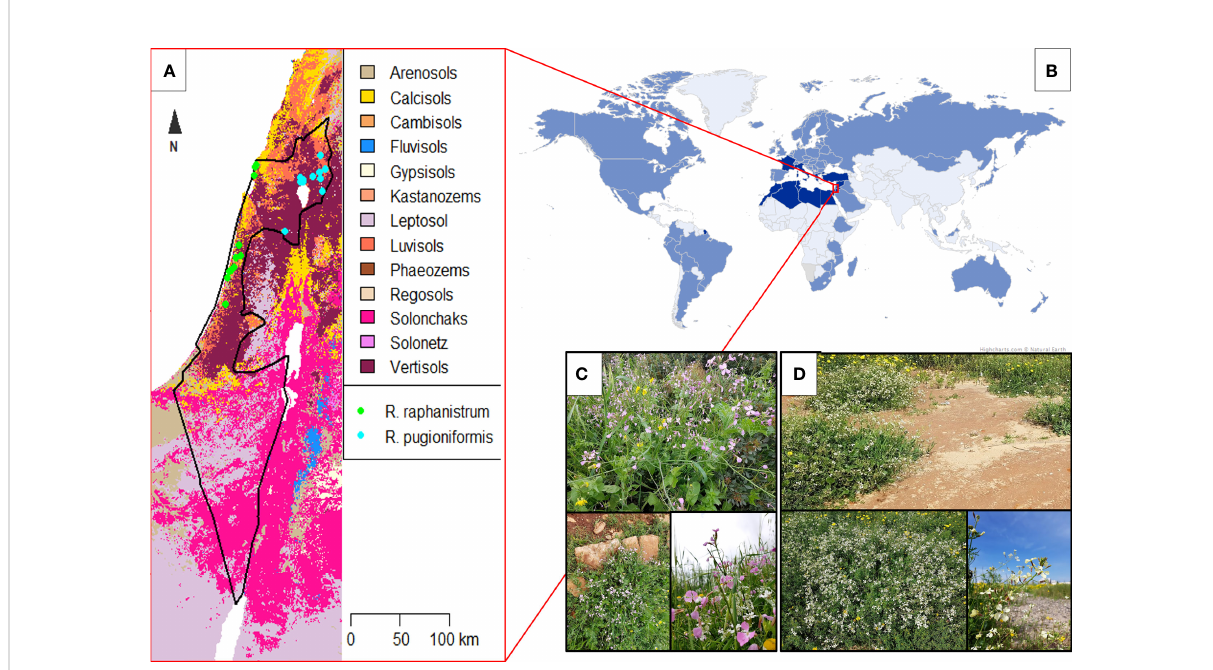
FIGURE 1 Distinct habit and non-overlapping distribution of Raphanus raphanistrum (a worldwide weed) and its relative, R. pugioniformis on corresponding soil types in Israel. (A) Recorded populations of R. raphanistrum (green dots) and R. pugioniformis (blue dots) were plotted on a soil map of Israel (Batjes et al., 2020). R. raphanistrum occurs mainly on sandy soils of coastal plains (=Calcisol), while R. pugioniformis is restricted to mountainous areas in north-eastern Israel on Terra Rossa (=Luvisol) and basaltic (=Vertisol) soils. (B) R. raphanistrum scattered worldwide (pale blue areas on the world map; (Holm et al., 1997)) from its native distribution area of the Mediterranean basin (highlighted by dark blue; (Ziffer-Berger et al., 2020)). R. pugioniformis is restricted to northern Israel, southern Lebanon, and Syria. (C) Representative native population of R. pugioniformis at Mt. Gilboa, Israel growing on Terra Rossa soil with high water retention. (D) Representative natural populations of R. raphanistrum growing on sandy soil (Hamra), which differ in several soil characteristics from Terra Rossa (pH value, nutrient availability, and water retention capacity), near the coastal plain at Tel Aviv, Israel. Worldwide distribution of R. raphanistrum is compiled from Holm et al. (1997) and plotted on Miller ’ s world projection (www.whighcharts.com, based on data from www.naturalearth.com). The soil map of Israel is prepared with the data from Soilgrids (www.soilgrids.org) with 250m